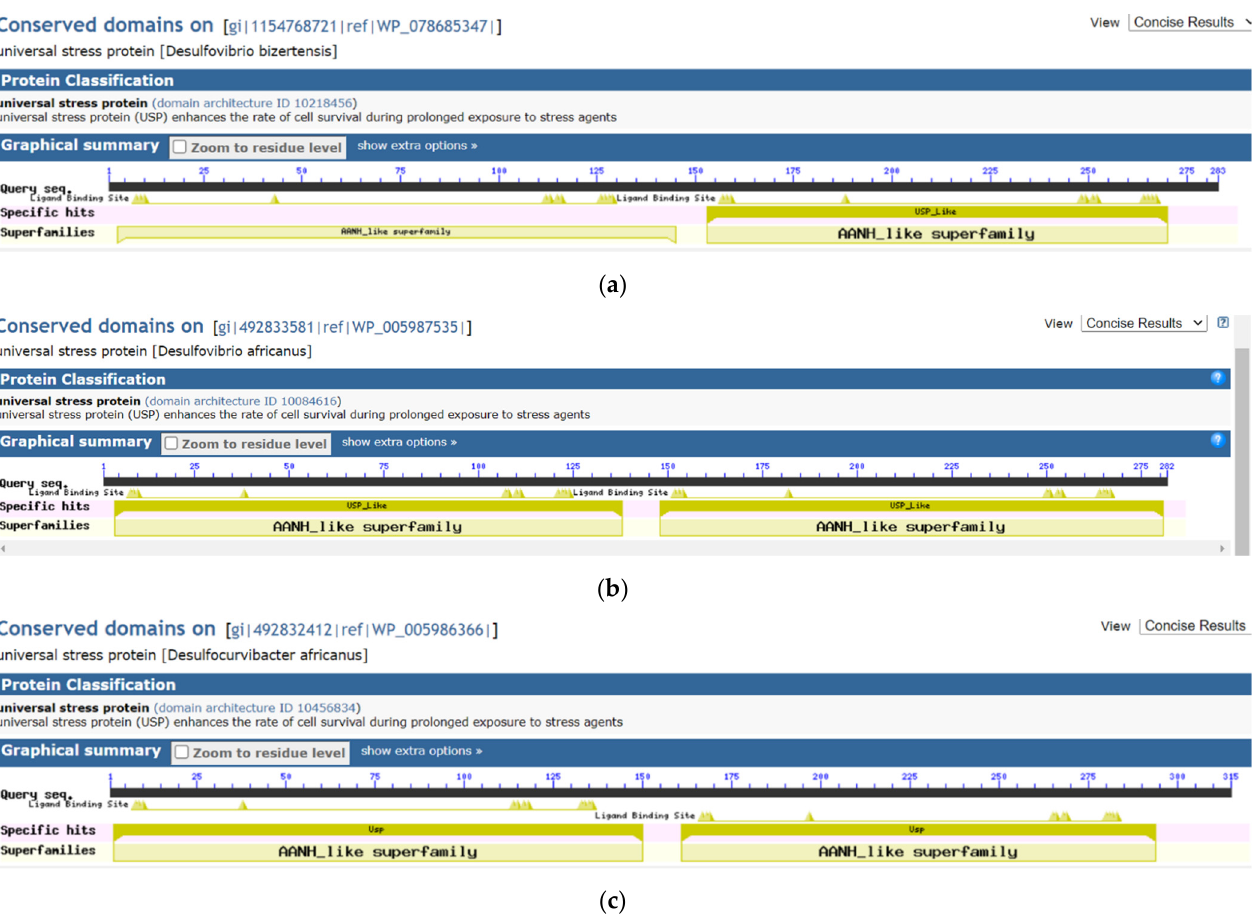
Figure 6. Protein domain compositions of three tandem-type universal stress proteins from mercury-methylating Desul- fovibrionaceae bacteria. ( a ) In WP_0005987535 of Desulfovibrio bizertensis DSM 18034, the USP domains do not have the same ATP-binding category. ( b ) In WP_005986366 of Desulfocurvicter africanus PCS, the USP domains are both ATP-binding. ( c ) In WP_005986366 of Desulfocurvicter africanus PCS, the two USP domains are not ATP-binding. Interactive version of each protein domain composition is available at the National Center for Biotechnology Information (NCBI) Conserved Domains resource by searching for the protein sequence identifier.